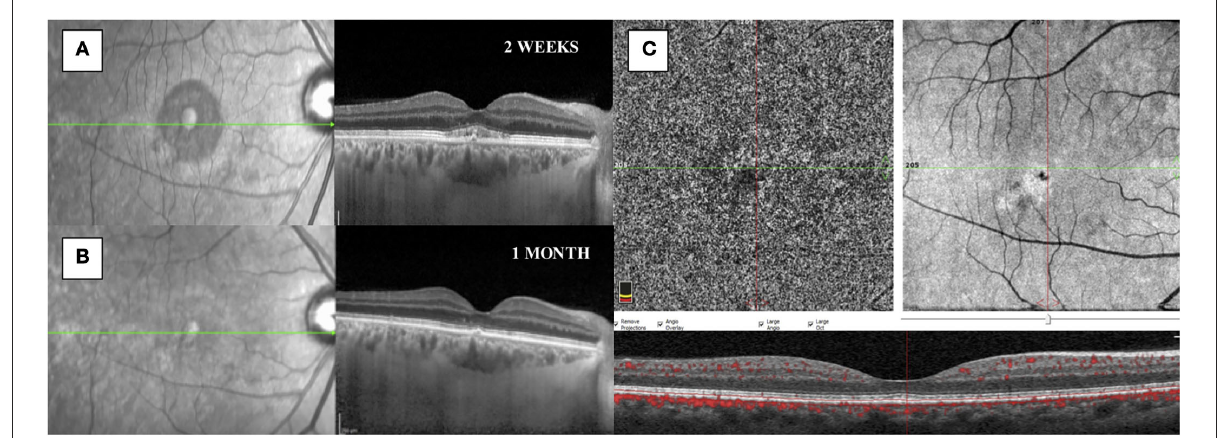
FIGURE3 (A) SD-OCT performed 2 weeks after subthreshold micropulse yellow laser therapy showed a reduction of the subretinal fluid with the presence of a flat irregular pigmented epithelial detachment and granular subfoveal material. (B) SD-OCT showed a complete resolution of the subretinal